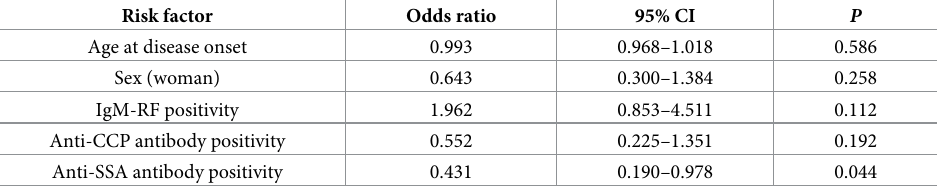
Table 3. Logistic regression analysis for the rate of achieving low disease activity based on the DAS28-CRP. Risk factor Odds ratio 95% CI P Age at disease onset 0.993 0.968–1.018 0.586 Sex (woman) 0.643 0.300–1.384 0.258 IgM-RF positivity 1.962 0.853–4.511 0.112 Anti-CCP antibody positivity 0.552 0.225–1.351 0.192 Anti-SSA antibody positivity 0.431 0.190–0.978 0.044 DAS28, 28-joint Disease Activity Score; CI, confidence interval; IgM-RF, IgM rheumatoid factor; anti-CCP, anti- cyclic citrullinated protein.